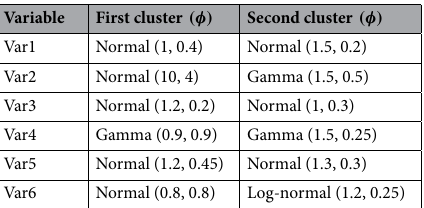
Table 1. Summary of the fitted univariate marginal distribution for each cluster. The numbers in the bracket refer to the marginals’ parameters.